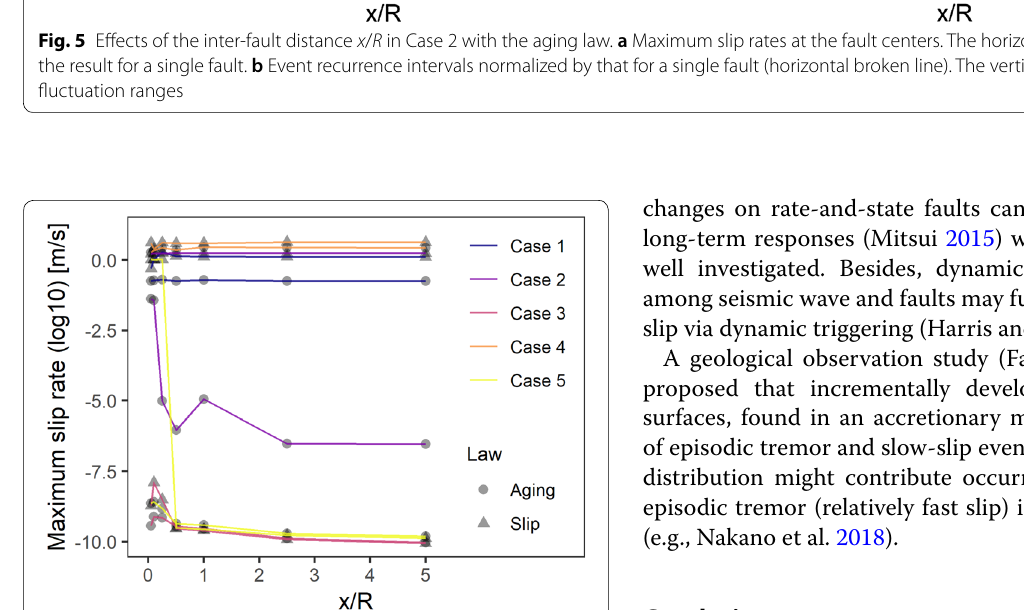
Fig. 6 Maximum slip rates (for both Faults 1 and 2) at the fault centers. The color lines represent the cases of the frictional parameters (Table 1), and the markers represent the state evolution laws of the rate-and-state-dependent